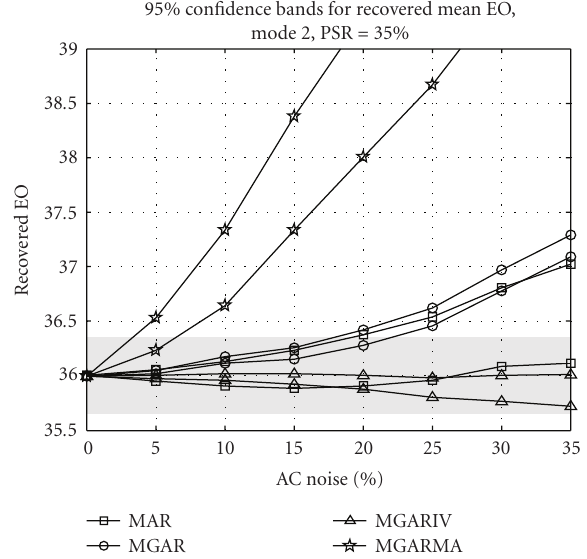
Figure 6: Test 1: 95% confidence bands for Prony-based methods: mode 2.